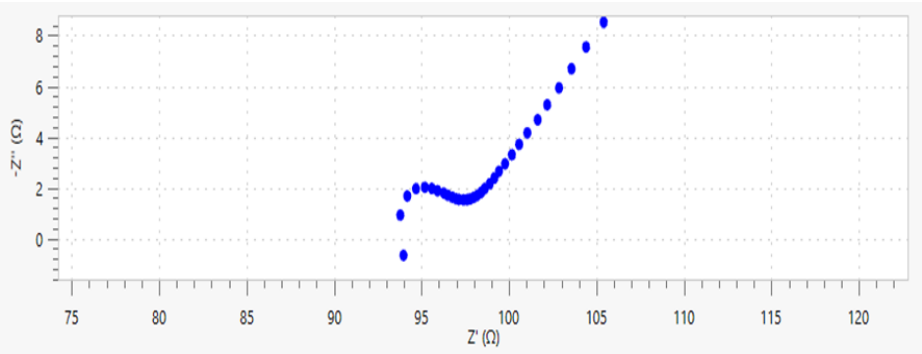
Figure 8. Typical Nyquist diagram of ionically conductive mortar.